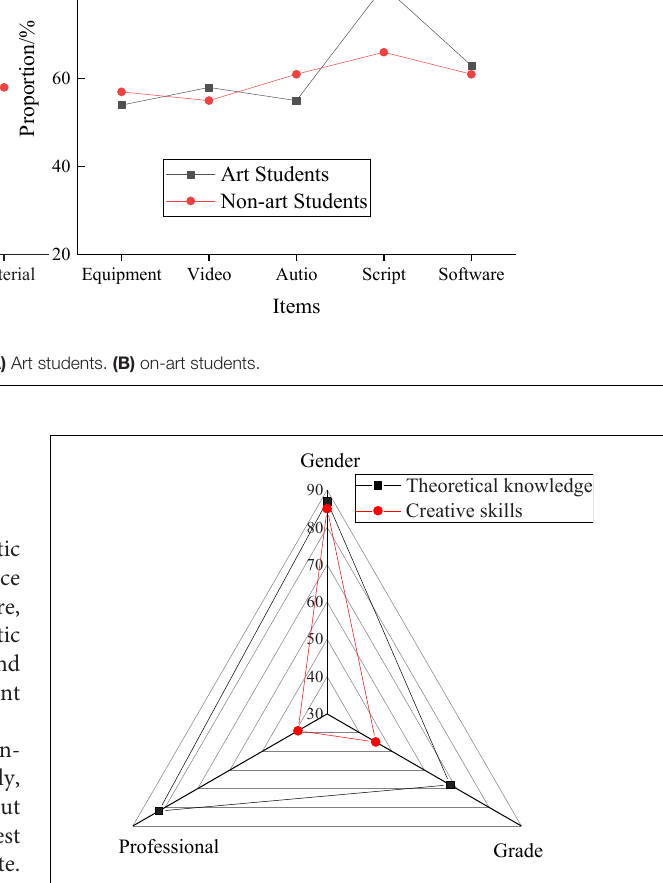
FIGURE 7 | Overall EPSY-based evaluation of the Cinematography teaching